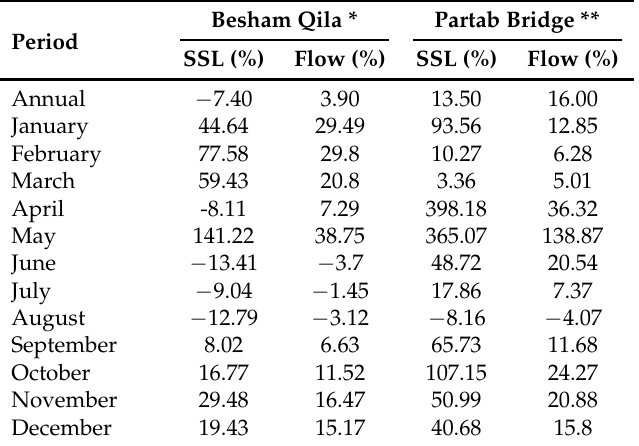
Table 6. Mean monthly linear variations in SSLs and discharges (flows) at both gauges (each month’s regression plots are presented in Figures S2 and S3 in the Supplementary Material).